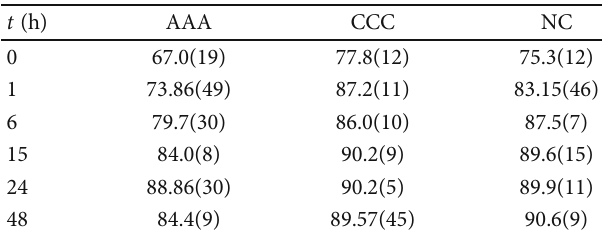
Table 3: Water contact angle θ on the di ff erently prepared gold samples after various times t in vacuum. The number in parentheses indicates the statistical uncertainty in the last decimal